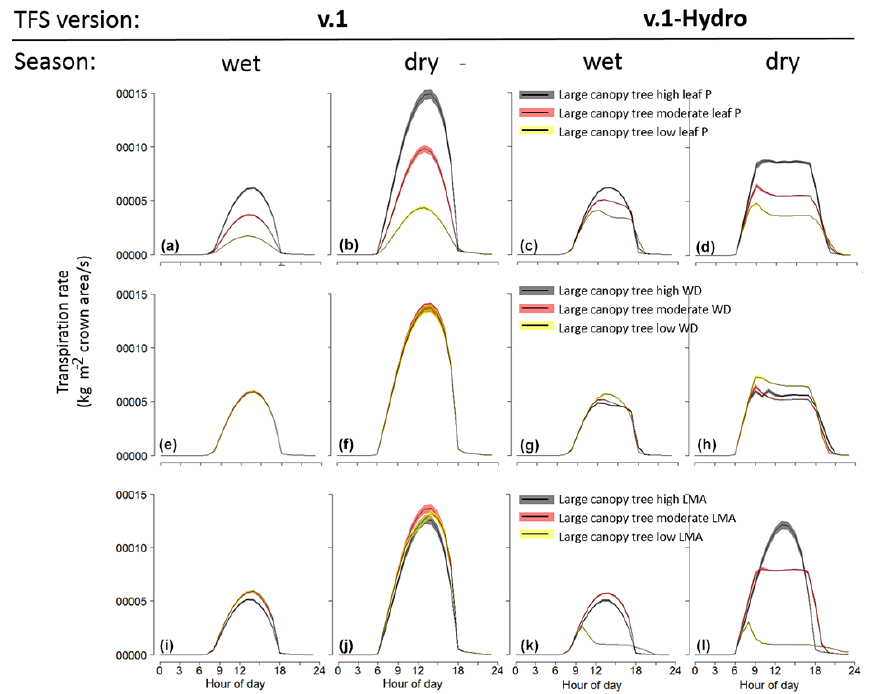
Figure 10. TFS simulated mean ( ± 1 SE) diurnal cycles of transpiration of three large (50–55cm DBH) individual trees receiving full sunlight but differing in one plant trait, stratified by wet/dry season and TFS version with (v.1-Hydro) and without (v.1) plant hydraulics implemented, at Caxiuana, Brazil. (a–d) Individuals differing in leaf P exhibit different light-saturated photosynthesis rates ( A max ) and consequently g s,max and, in v.1-Hydro, k s,max . (e–h) Individuals differing in wood density WD exhibit no difference in maximum transpiration rate per unit crown area in v.1, but different rates in v.1-Hydro emerge due to differences in xylem safety ( P 50,x ) and, hence, stomatal control ( P 50,gs ) . (i–l) Individuals differing in leaf mass per area LMA exhibit little difference in v.1 but large differences in v.1-Hydro, due to large differences